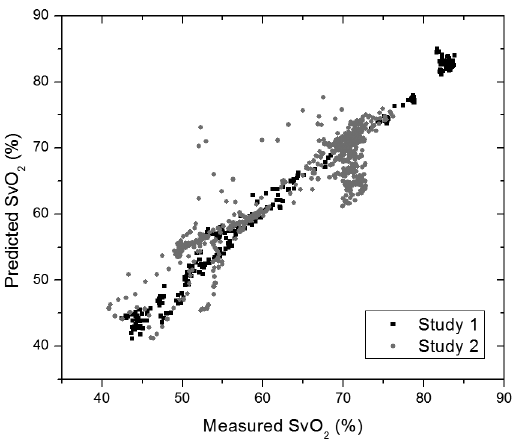
Figure 7. Scatter plot of the predicted (telemetry) versus measured (catheter) venous oxygen saturation for both studies (1: black & 2: grey).